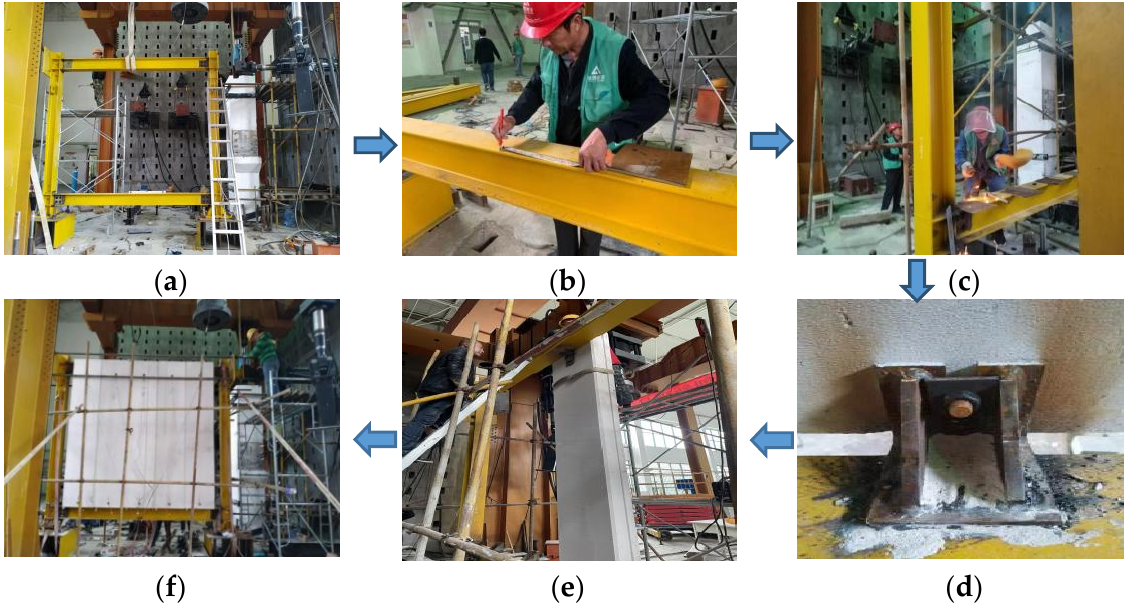
Figure 7. Connector installation schematic: ( a ) assembling steel frame; ( b ) positioning of the connector; ( c ) welding bracket plate; ( d ) welding connector; ( e ) panel lifting; ( f ) applying caulking mor- tar.